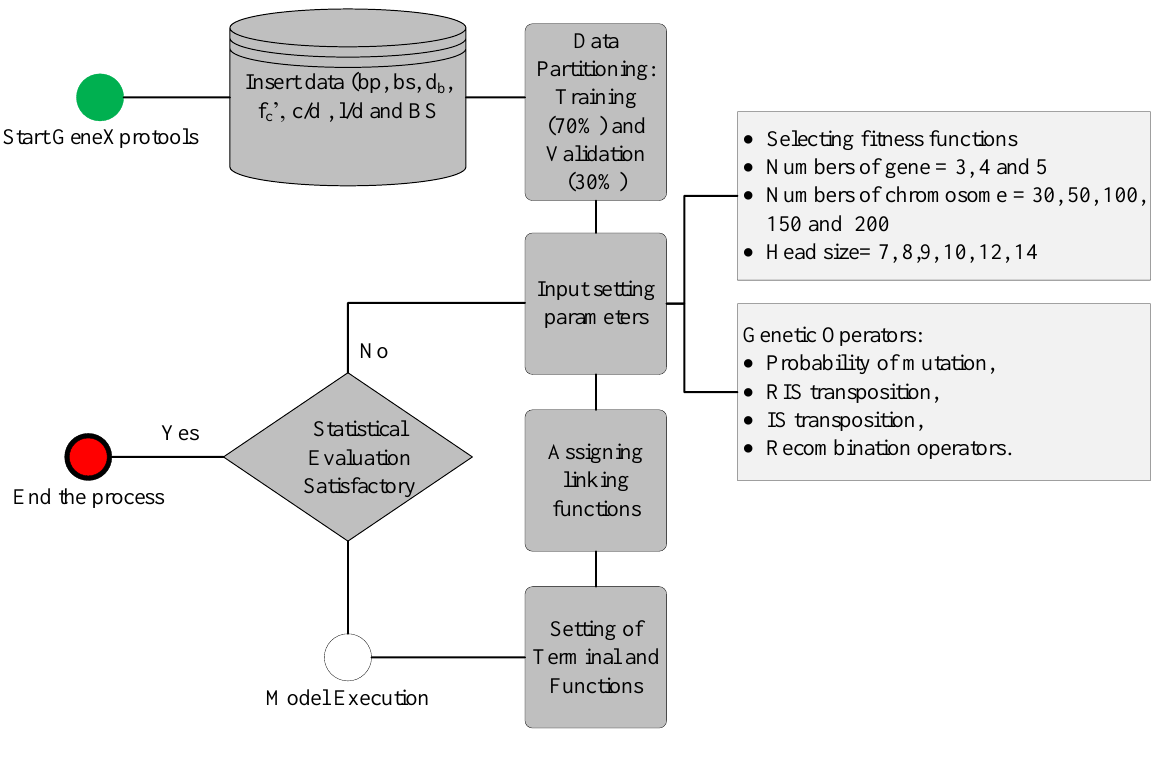
Table 2. Details of the trials scrutinized in this study.